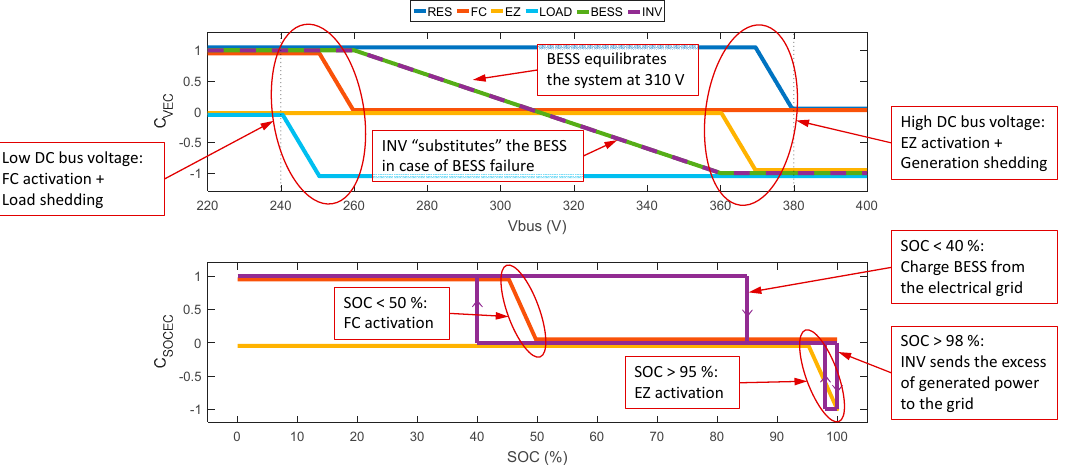
Figure 2. E-BCS control laws: VEC in the graph above and SOCEC in the graph below.